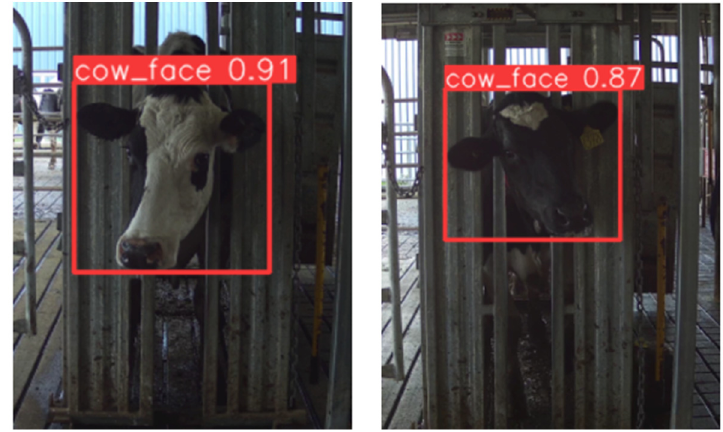
Figure 3. Example of face detection showing the confidence score.